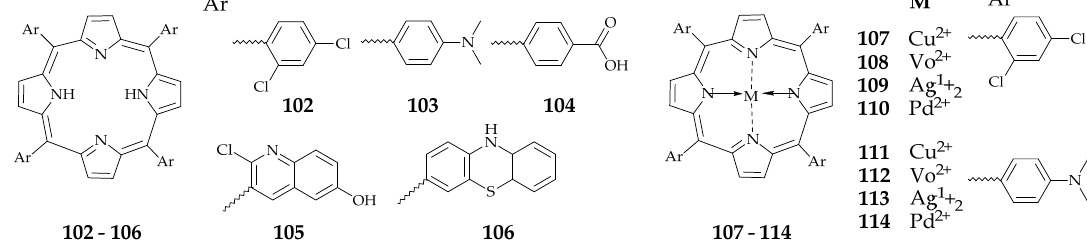
Figure 16. Structures of porphyrin derivatives 93 – 101 . Figure 17. Structures of porphyrin derivatives 102 – 114 . Figure 17. Structures of porphyrin derivatives 102 – 114